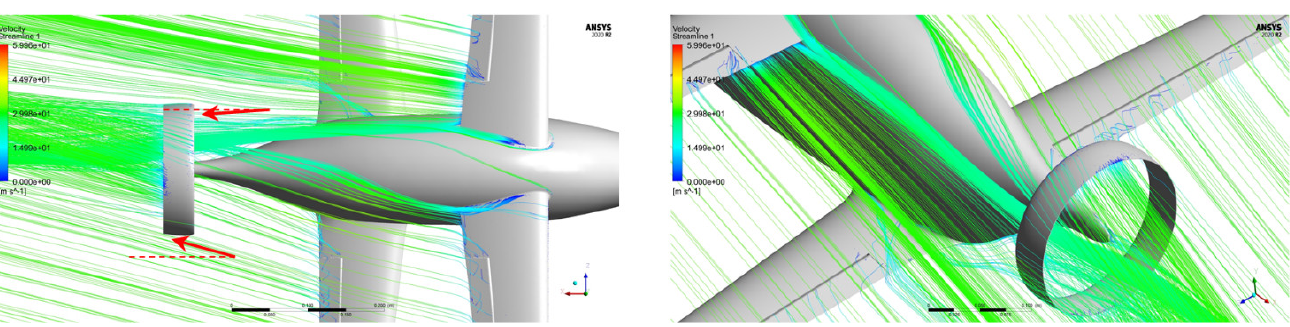
Pressure coef- ficient visuali- zation in a horizontal mid-section plane Inner (shaded) section Flow